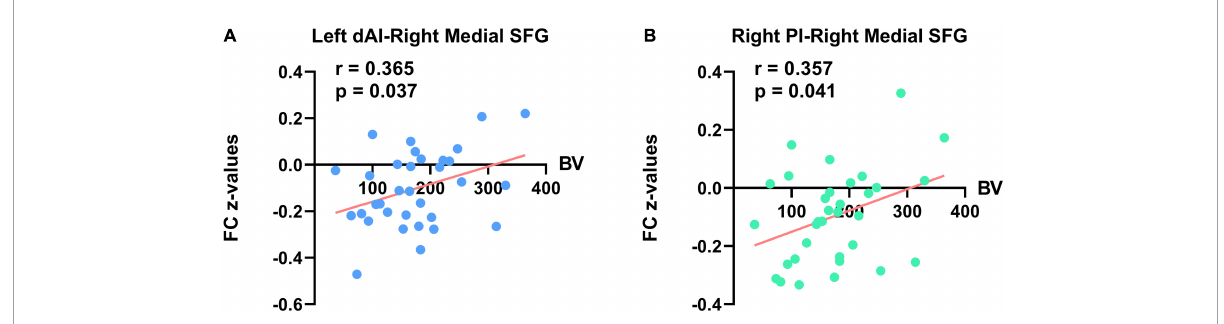
FIGURE4 Significant correlations between bladder volume (BV) and FC z -values of the insula with other brain regions in PNE subjects (with global signal regression). The (A) left panel indicates a significant positive correlation between rsFC of left dAI with right medial SFG and BV. The (B) right panel indicates a significant positive correlation between rsFC of right PI with right medial SFG and BV. dAI, dorsal anterior insula; SFG, superior frontal gyrus; PI, posterior